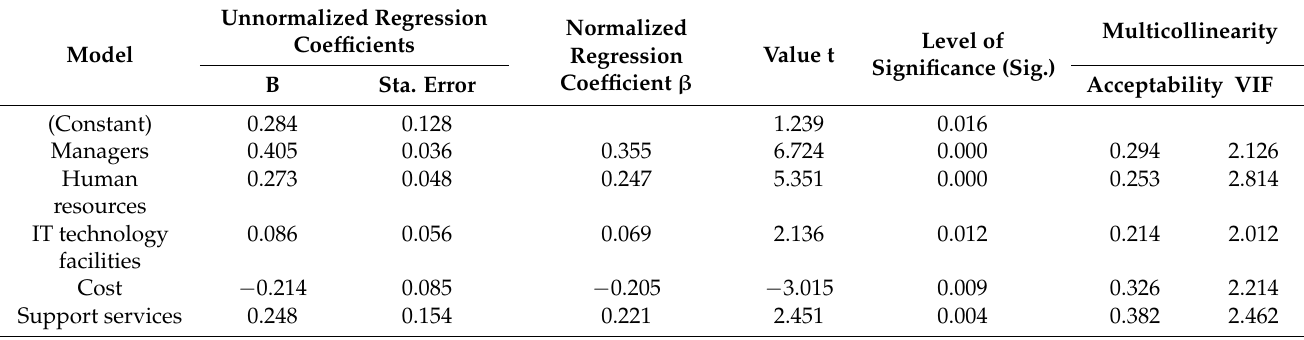
Table 4. Results of multivariate